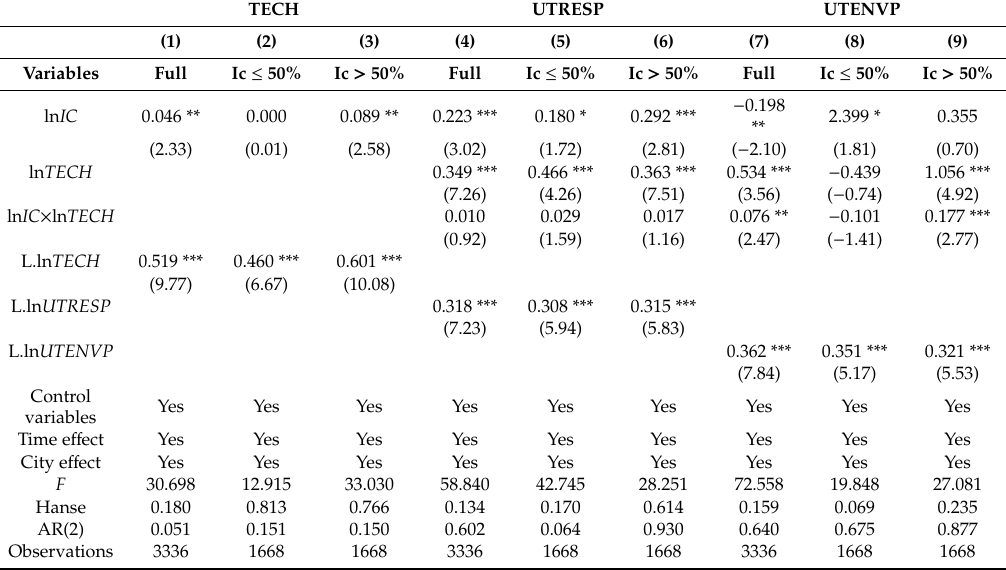
Table A4. Robust analysis of technology innovation and di ff usion e ff